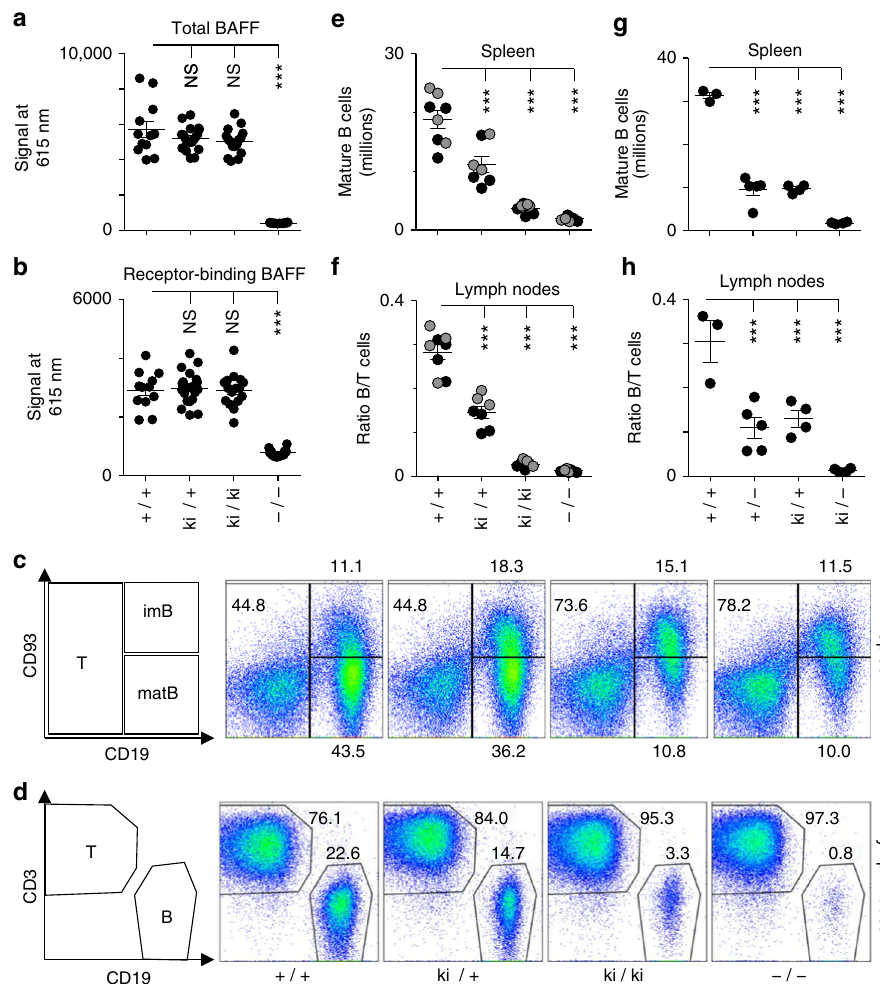
Fig. 3 Reduced numbers of mature B cells in BAFF E247K knock-in mice despite normal circulating level of BAFF competent for receptor binding. a Relative levels of circulating BAFF were measured in a homogeneous ELISA-like assay (AlphaLisa) using a pair of anti-mBAFF antibodies (5A8 and Sandy-2) in the serum of Baff wt/wt ( + / + ) ( n = 12), Baff wt/E247K (ki/ + ) ( n = 20), and Baff E247K/E247K (ki/ki) ( n = 16) littermates and in the serum of Baff − / − ( − / − ) ( n = 12) mice. Mean± SEM. One-way Anova followed by Bonferroni comparing + / + to other genotypes. NS = not signi fi cant: p > 0.05; *** p < 0.001. The experiment was performed twice. b Same as panel a , except that BAFF was measured with one soluble receptor (TACI-Fc) and one anti-mouse BAFF antibody (Sandy-2). The experiment was performed once. c Flow cytometry analysis of lymphocytes with T cell (CD19 − , CD93 − ), mature B cell (matB) (CD19 + , CD93 low ), and immature B cell (imB) (CD19 + , CD93 + ) phenotypes in spleens of mice of the indicated genotypes. Percentages of cells in each quadrant are indicated. d Same as panel c , but for T (CD3 + ) and B (CD19 + ) lymphocytes in lymph nodes. e Number of B cells in spleens of 7 mice per group (8 mice for WT) of the indicated genotypes from two pooled experiments differentiated by black and gray circles. Mean ± SEM. One-way Anova followed by Bonferroni comparing + / + to other genotypes. *** p < 0.001. f Same as panel e , but showing B to T cell ratio in lymph nodes. g Number of mature B cells in spleens of mice (4 mice per group, 3 for WT, 5 for + / − ) of the indicated genotypes, all littermates. Mean ± SEM. One-way Anova followed by Bonferroni comparing + / + to other genotypes. *** p < 0.001. The experiment was performed once in this format (and twice comparing + / + , + / − , and − / − ). h Same as panel g , but showing B to T cell ratio in lymph nodes. See also Supplementary Figs. 2, 3, and 4, and Supplementary Tables 1 and